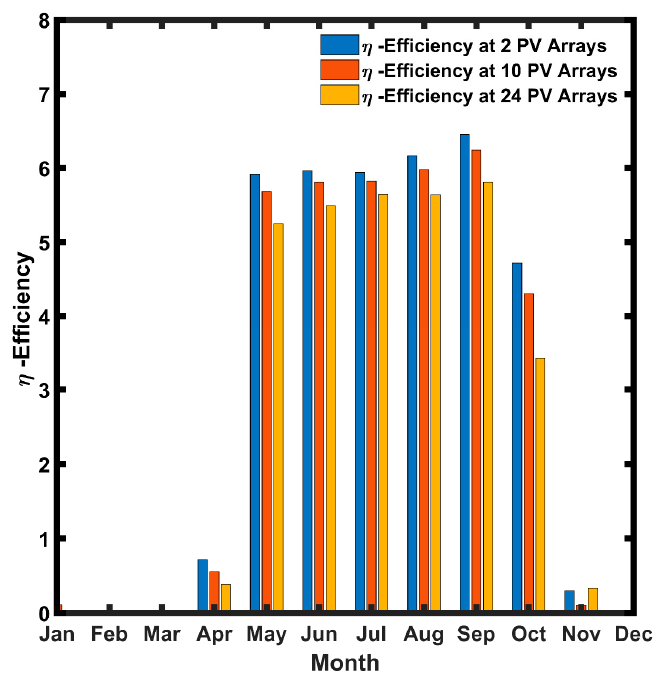
Figure 8. Average annual efficiency improvements of the PV panels for a year vs. the number of PV panel arrays.